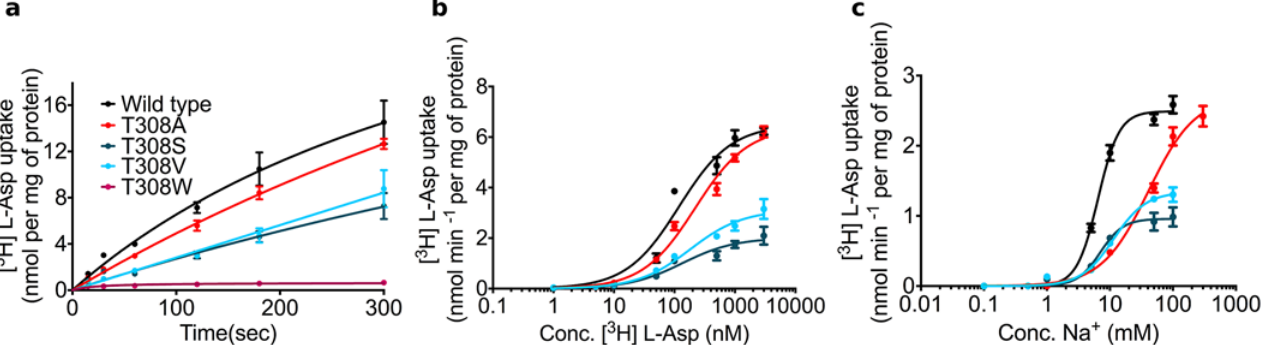
Fig 6. Effects of T308 mutations on substrate uptake. (a) Uptake of [ 3 H] L-aspartate into GltPh containing proteoliposomes. We could not observe aspartate uptake for the T308W mutation. (b) [ 3 H] L-aspartate uptake into proteoliposomes as a function of [ 3 H] L-aspartate concentration and (c) [ 3 H] L- aspartate uptake into proteoliposomes as a function of sodium concentration. The data are from three independent experiments; error bars show s.e.m.